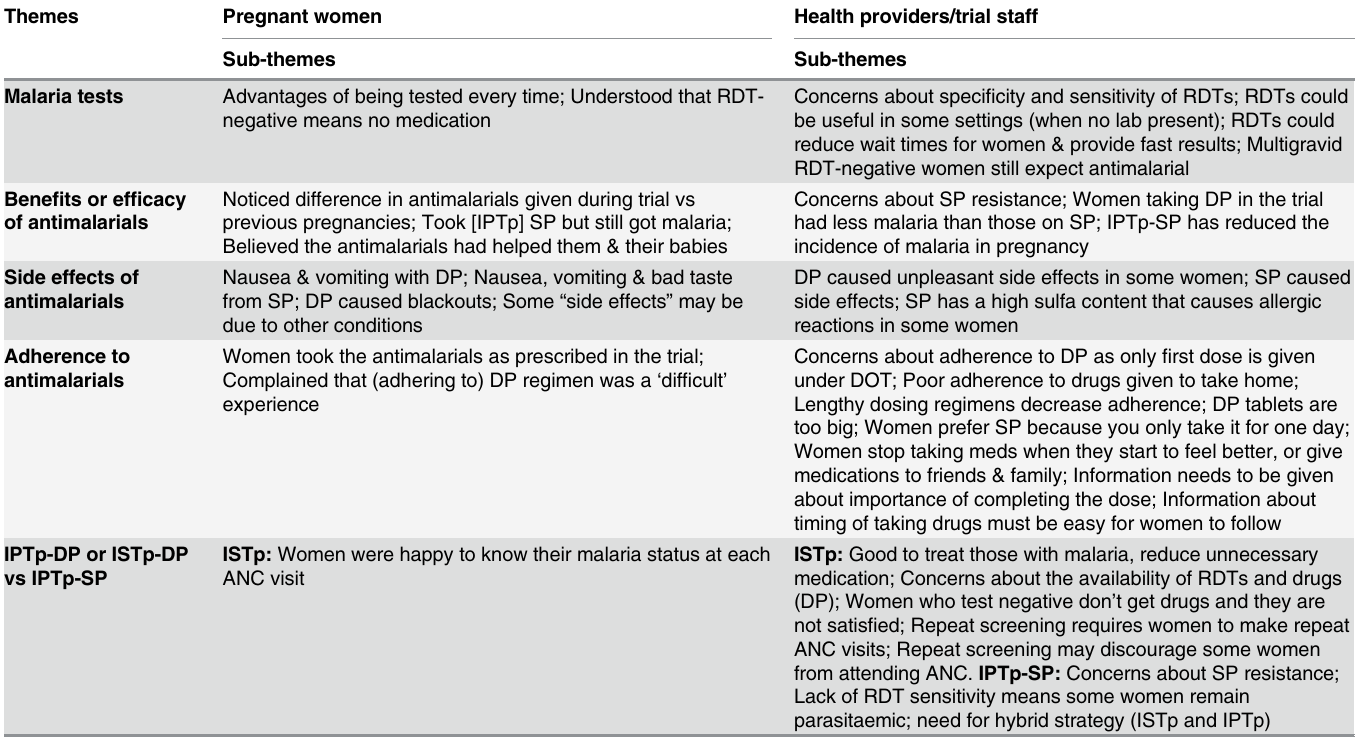
Table 4. Experiences and perceptions on the acceptability of IPTp-DP or IST-DP vs IPTp-SP among trial participants, trial staff and health